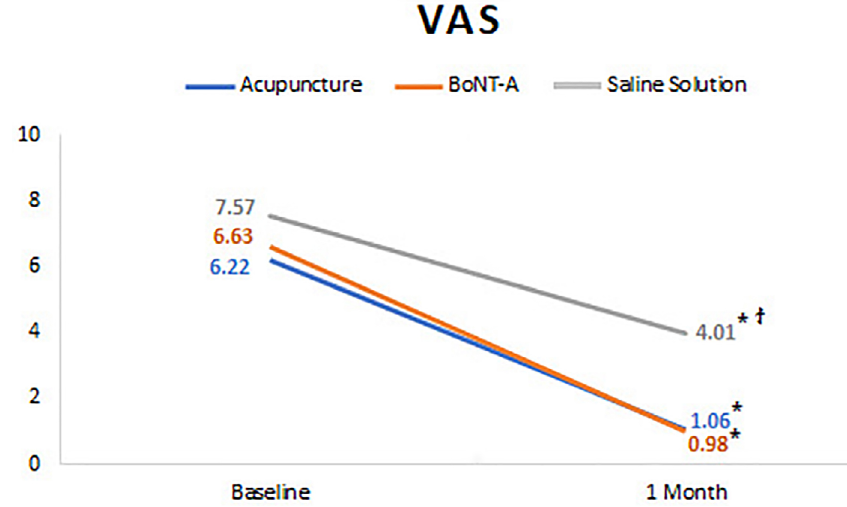
Figure 3- Self-perceived pain (VAS) values for each group, before and after treatments. ϯ represent significant differences among groups (P<0.05); * represent significant differences among time points